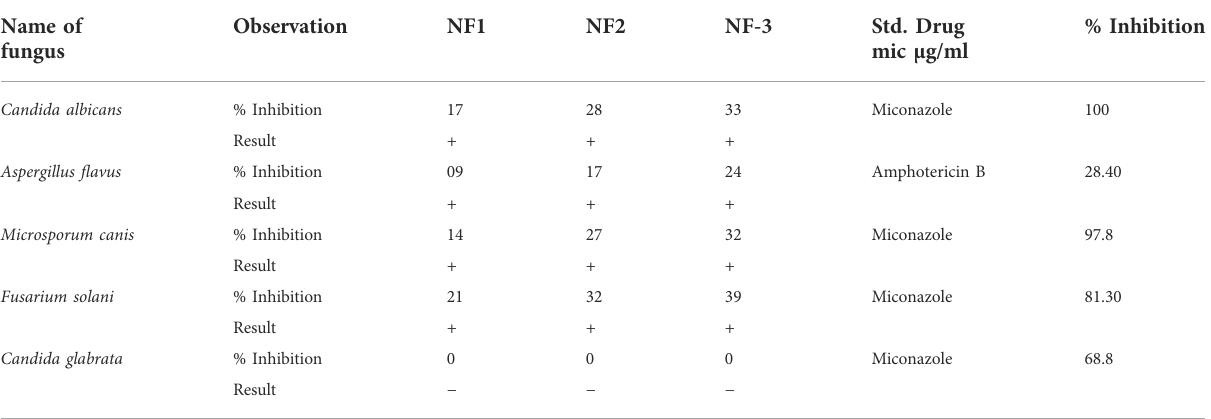
TABLE 1 Antifungal activities of prepared nano fi bers. Name of fungus